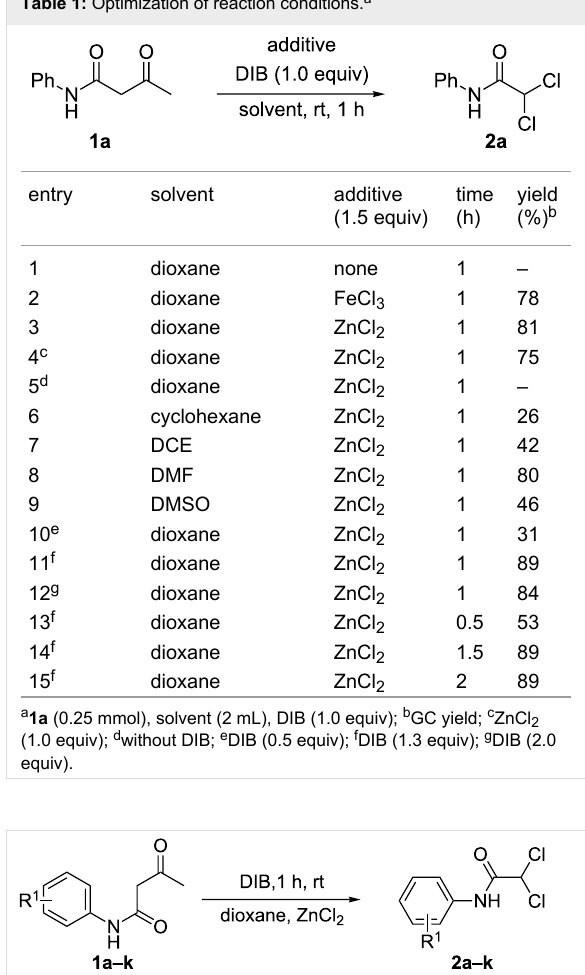
Table 1: Optimization of reaction conditions. a